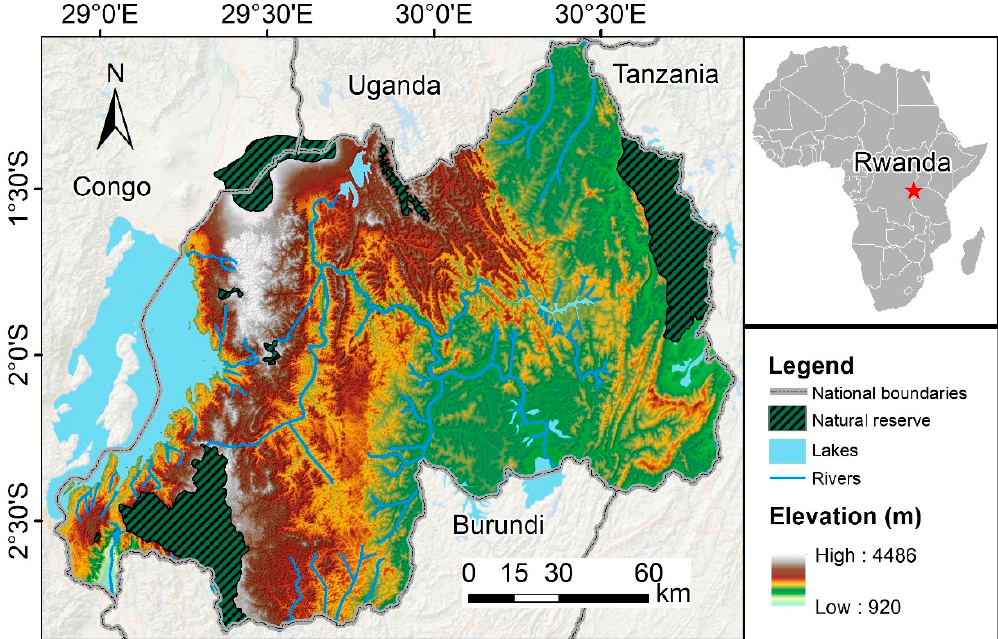
Figure 1. Location of the study area.